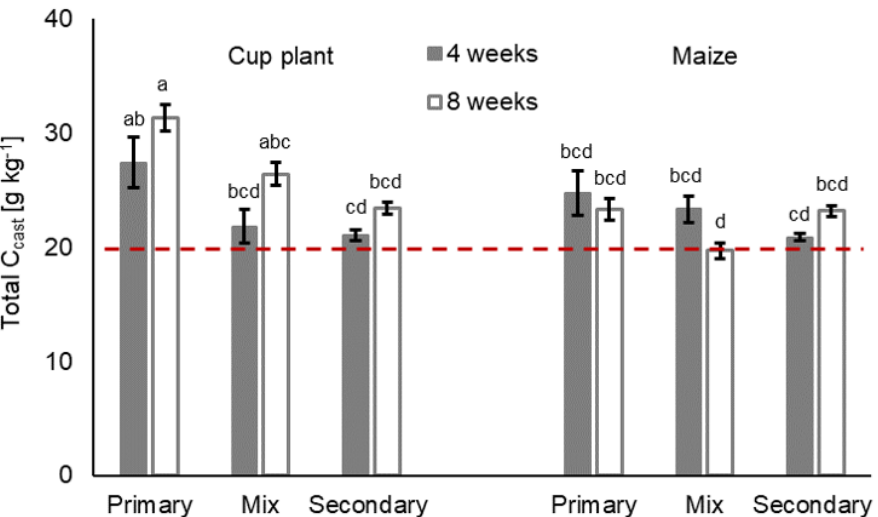
Figure 4. Total carbon C cast [g kg − 1 ] (means ± SE, n = 5) in casts in treatments with primary decomposers L. terrestris (‘primary’), secondary decomposers A. caliginosa and A. rosea (‘secondary’) and a mix of primary and secondary decomposers (‘mix’) in cup plant and maize treatments after 4 and 8 weeks of incubation. Initial total soil carbon content is expressed by the dashed red line. For statistics see Table 3 and Supplementary Information Table S6; for further information see Supplementary Information, Table S4.